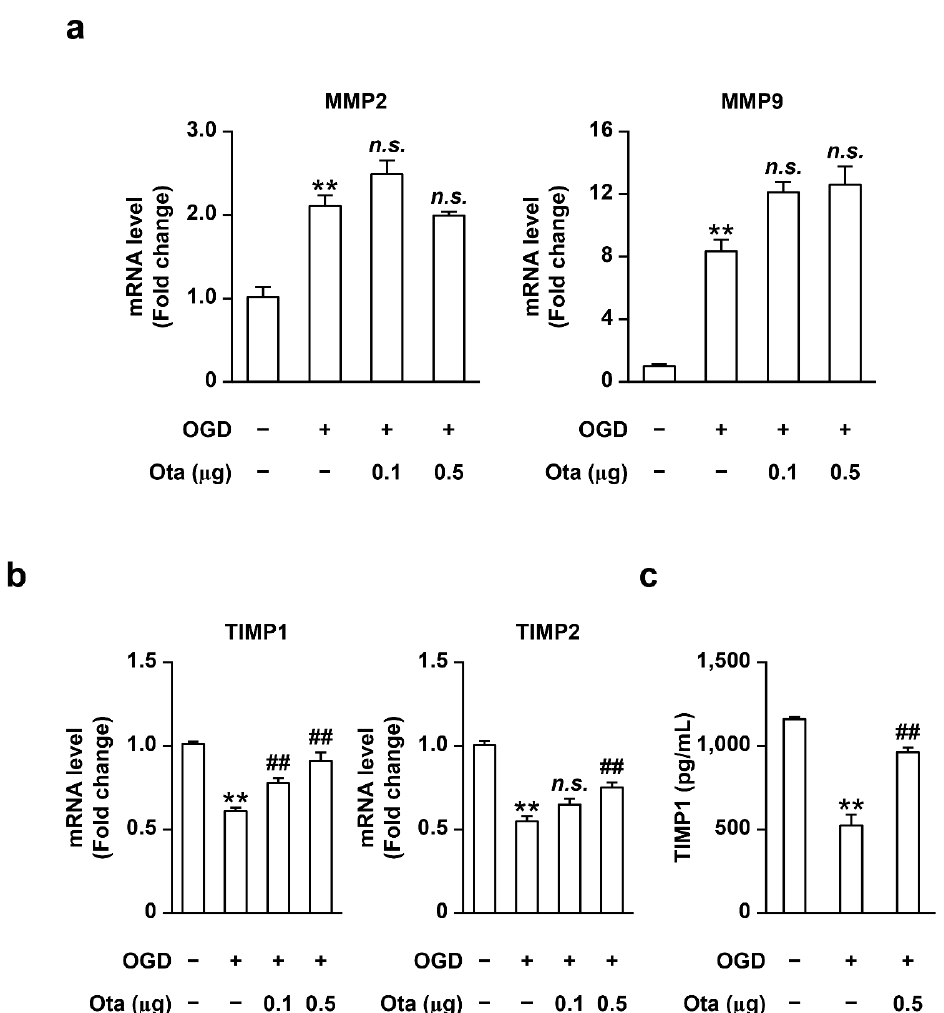
Figure 3. Effects of otaplimastat (Ota) on MMP and TIMP mRNA expression in bEND3 cells. ( a ) MMP-2 and MMP-9 mRNA levels. ( b ) TIMP1 and TIMP2 mRNA levels. ( c ) TIMP1 protein levels in the supernatant. Experimental bEnd3 cells were treated with OGD for 6 h in the absence or presence of otaplimastat (0.1 and 0.5 µ M). Data are presented as means ± S.E.M and analyzed with Kruskal–Wallis followed by Mann–Whitney test (** p < 0.01 vs. normoxia, ## p < 0.01 vs. OGD treated